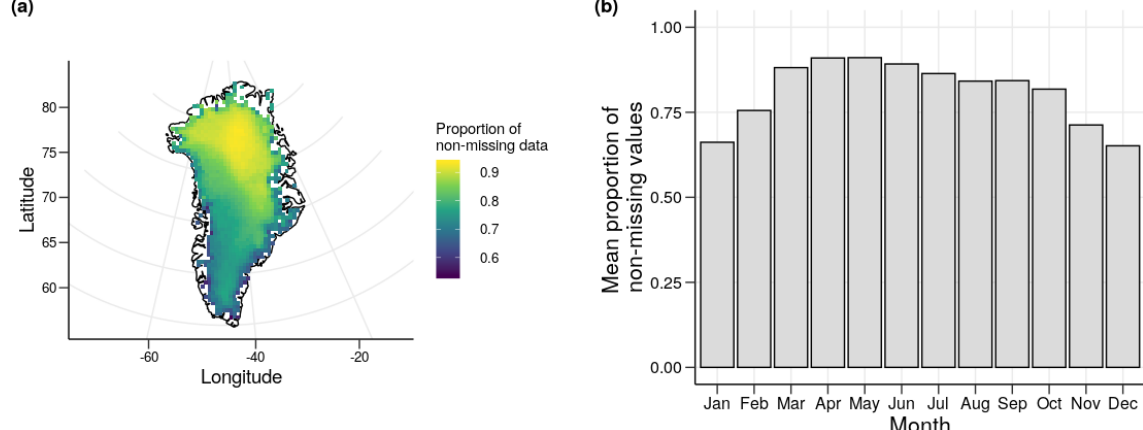
Figure 1. Proportion of available MODIS IST data (i.e. not filtered by the cloud mask) at 1139 cells on the Greenland ice sheet between 2001 and 2019 (a) and mean proportion of available MODIS IST data by month between 2001 and 2019 (b) .